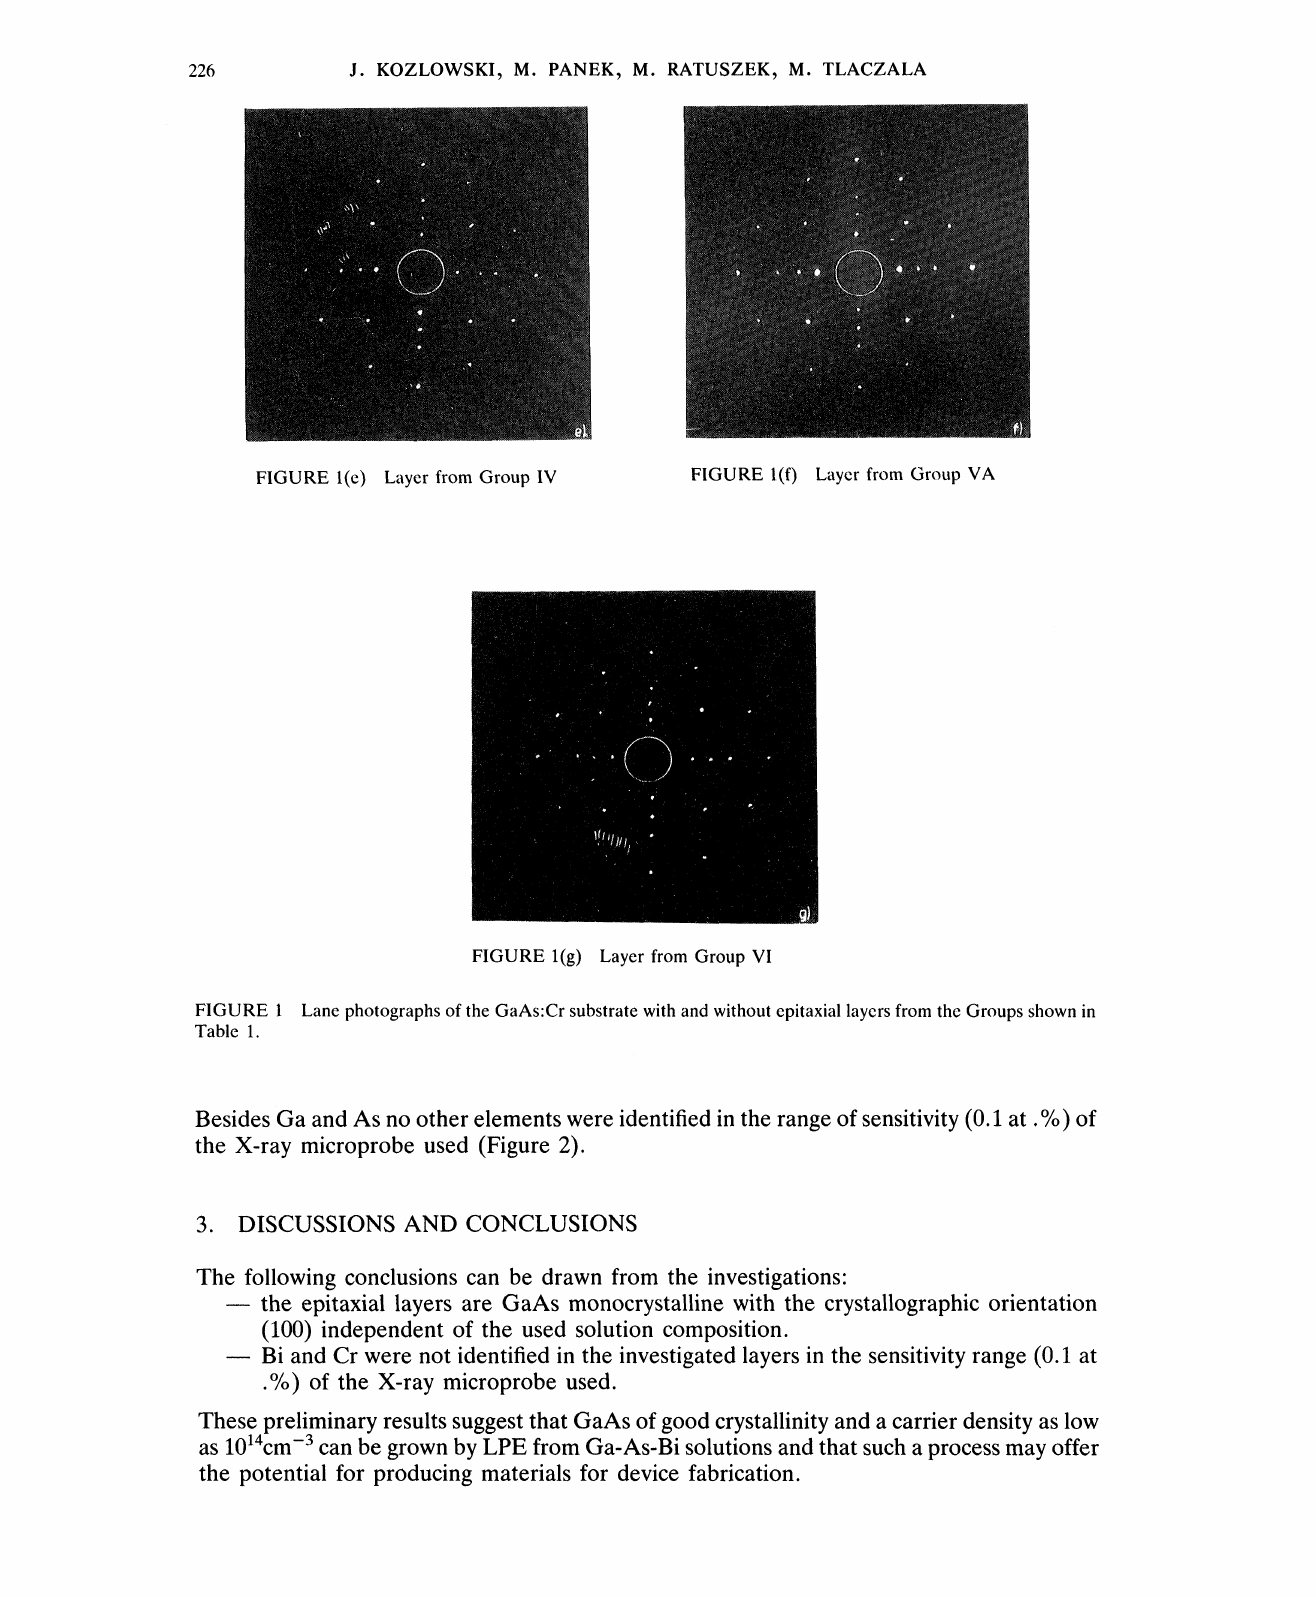
Besides Ga and As no other elements were identified in the range of sensitivity (0.1 at. %) of the X-ray microprobe used (Figure